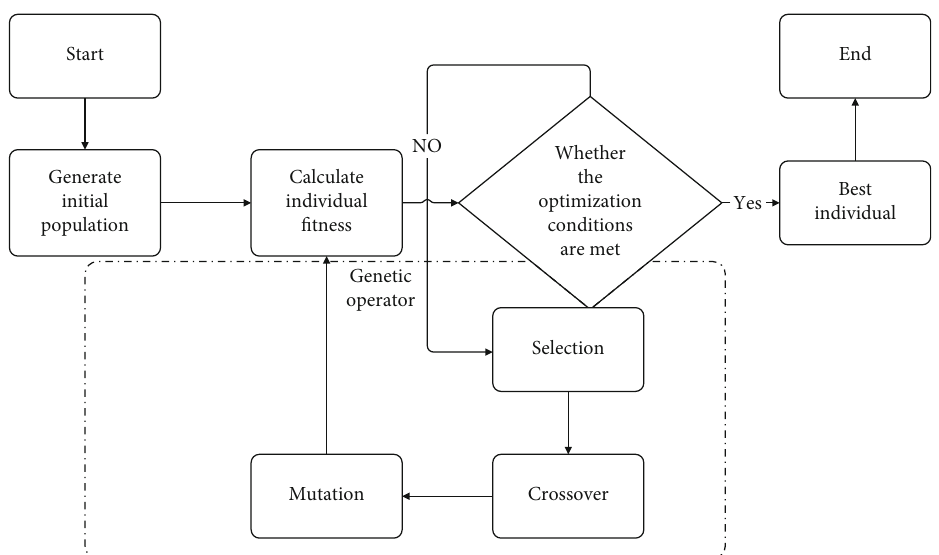
Figure 12: Flow chart of main steps of genetic algorithm.